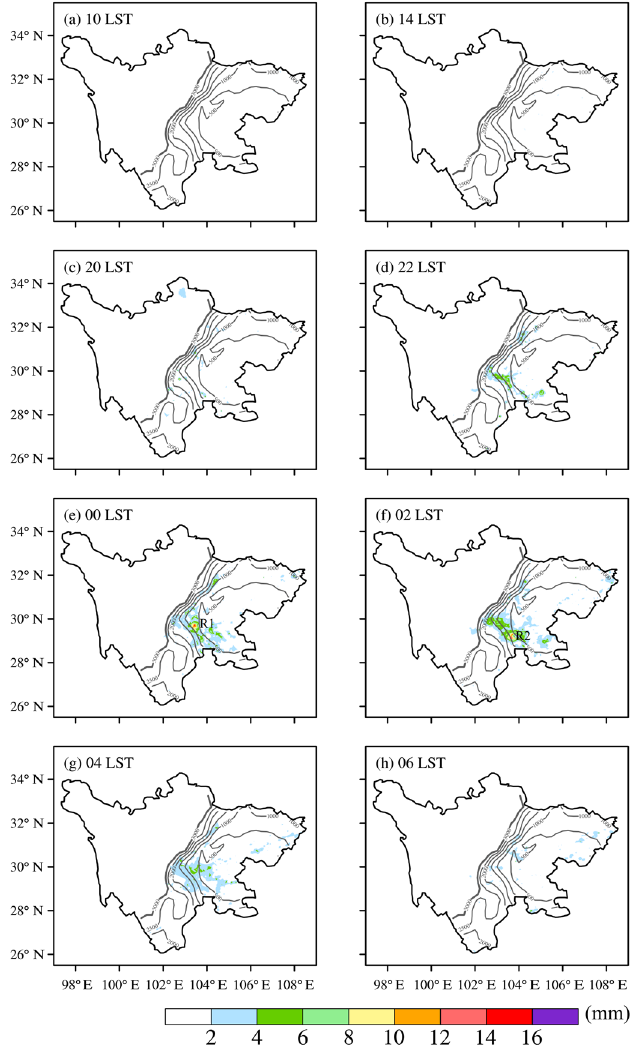
Figure 3. The temporal and spatial distribution of rainstorms at ( a ) 10 LST, ( b ) 14 LST, ( c ) 20 LST, ( d ) 22 LST, ( e ) 00 LST, ( f ) 02 LST, ( g ) 04 LST, and ( h ) 06 LST. Gray solid line represents terrain height, bolded solid line indicates the altitude of 3000 m. R1 and R2 represent rainstorm center stations.